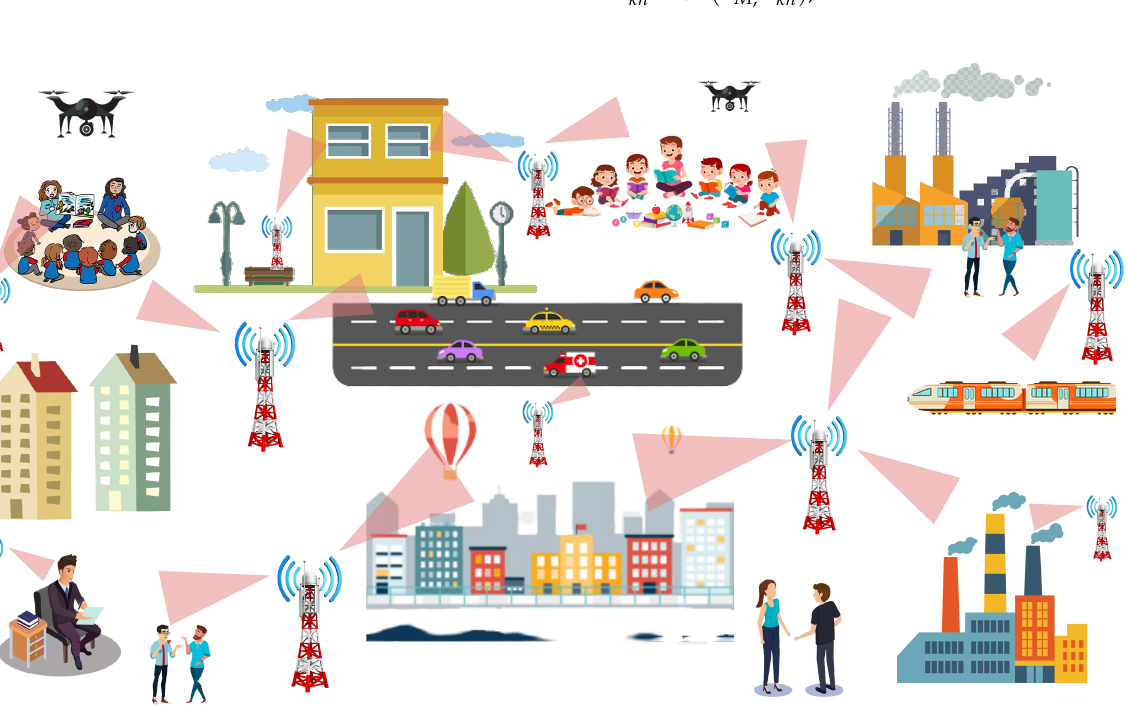
Figure 1. Deployment scenario of cell-free mMIMO empowered 6G massive IoT network, demon- strating respective use